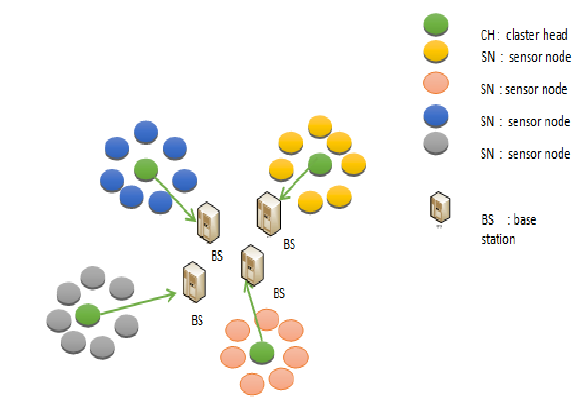
Figure 2 . Scenarios with multiple BSs